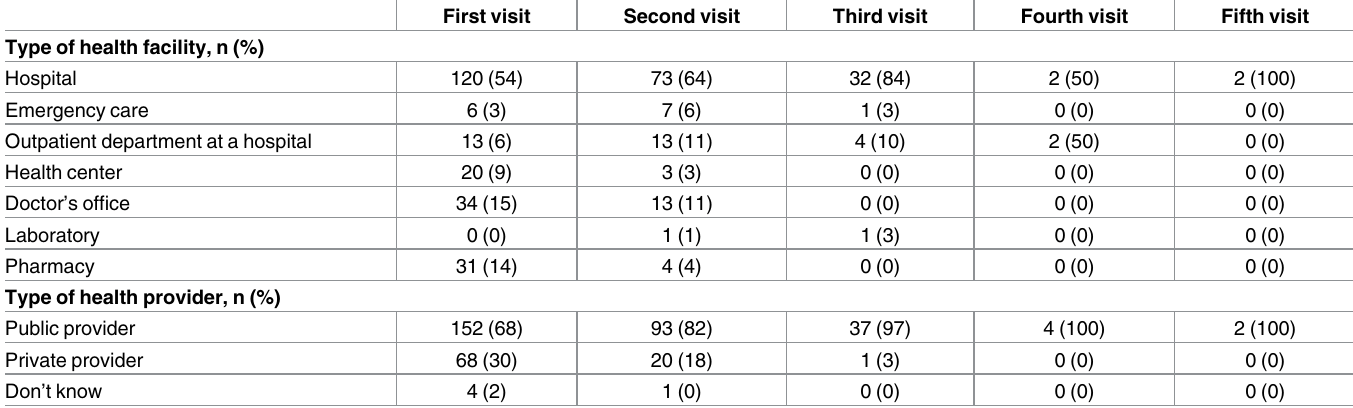
Table 3. Type of health facilities visited and health providers consulted by hospitalized dengue patients, Chacheongsao province, Thailand, 2015.